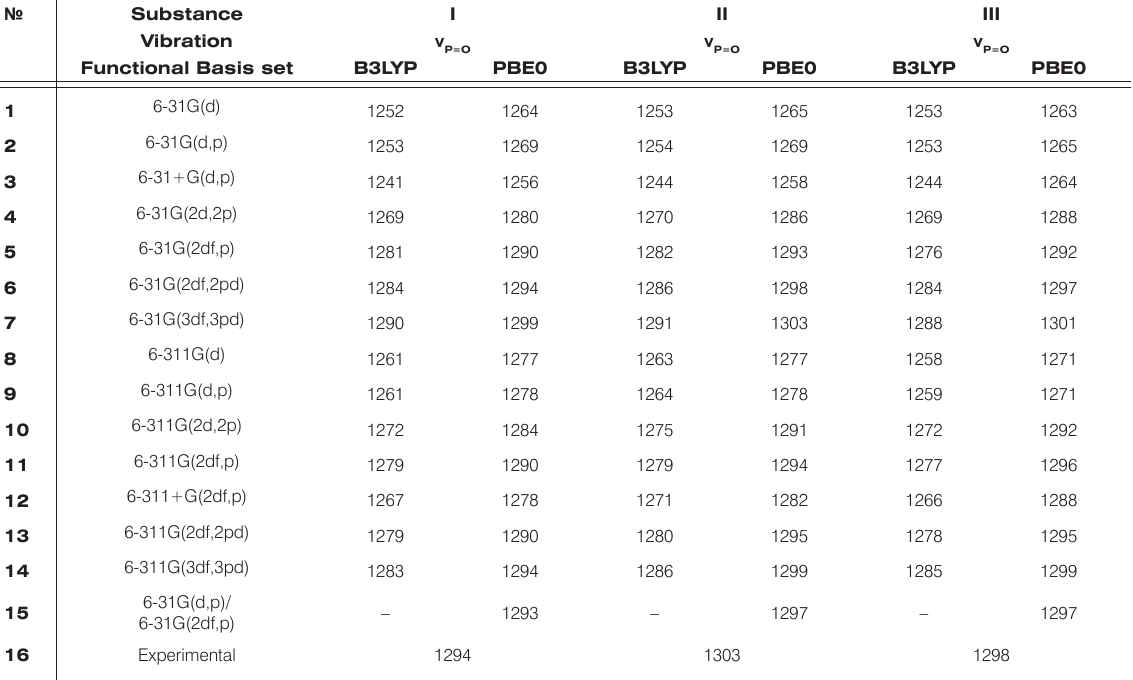
Table 5. Frequencies of P=O stretching vibration (cm -1